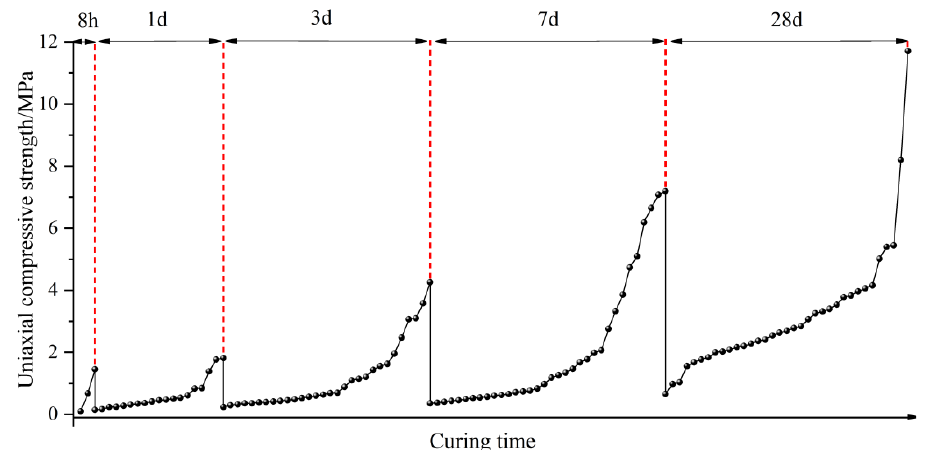
Figure 24. Uniaxial compressive strength of high-water filling material at different curing ages [22,78,80,81,84 –